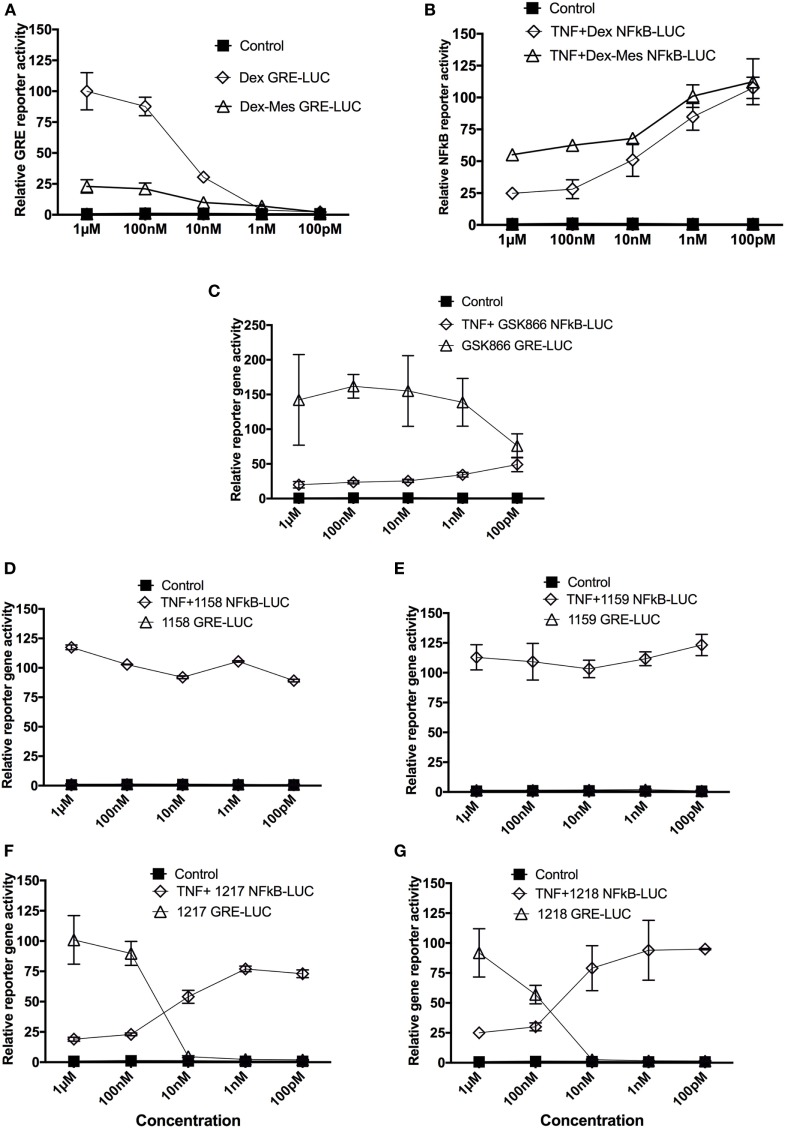
Selective glucocorticoid receptor agonist GSK866 analogs UAMC-1217, UAMC-1218 but not UAMC-1158 and UAMC-1159 elicit selective glucocorticoid receptor-transactivation and NFκB-transrepression properties. Glucocorticoid response element (GRE)- and NFκB-luciferase-dependent reporter gene assays were performed in L929sA and HaCat reporter cells which were stably transfected with, respectively, p(NFκB)3-50luc or p(GRE)2-50-luc constructs. For p(GRE)2-50-luc reporter assays, cells were solvent-treated or induced with different concentrations of Dex (A), Dex-mesylate (Dex-Mes) (A), SEGRA GSK866 (C) or analogs UAMC-1158 (D), UAMC-1159 (E), UAMC-1217 (F), and UAMC-1218 (G) as indicated for a total exposure time of 6 h, whereas cells were cotreated for TNF (2,500 IU/ml) in the last 4 h for p(NFkB)3-50luc reporter assays (B–G). Corresponding lysates were assayed for luciferase activities and normalized for protein content as described in the Section “Materials and Methods.” Promoter activities are expressed as relative induction factor (± standard deviation) i.e., the ratio of expression levels recorded either at induced and non-induced conditions, with the latter taken to be 1.